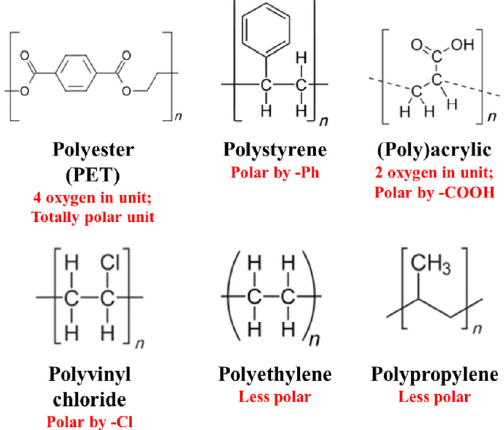
Fig. 6 The configuration and characteristics of the polymers.